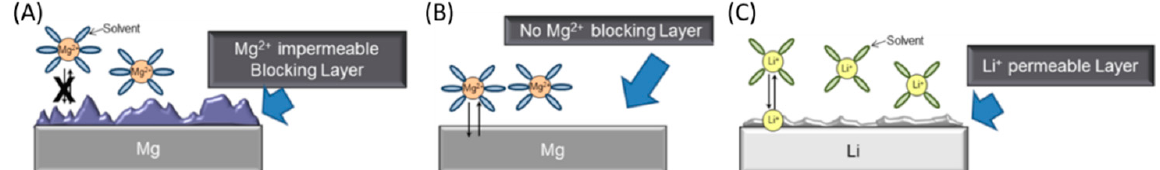
Figure 5. The metal/electrolyte interfaces for ( A , B ) magnesium- and ( C ) lithium-based systems. Different from lithium, magnesium experiences passivation when the metal is exposed to conventional electrolytes (case A, e.g., with ionic salts and polar solvents), while magnesium passivation does not occur in ethereal organo-magnesium electrolytes (case B, e.g., with Grignard-based solutions). Adapted with permission from [71]. Copyright Beilstein-Institut,